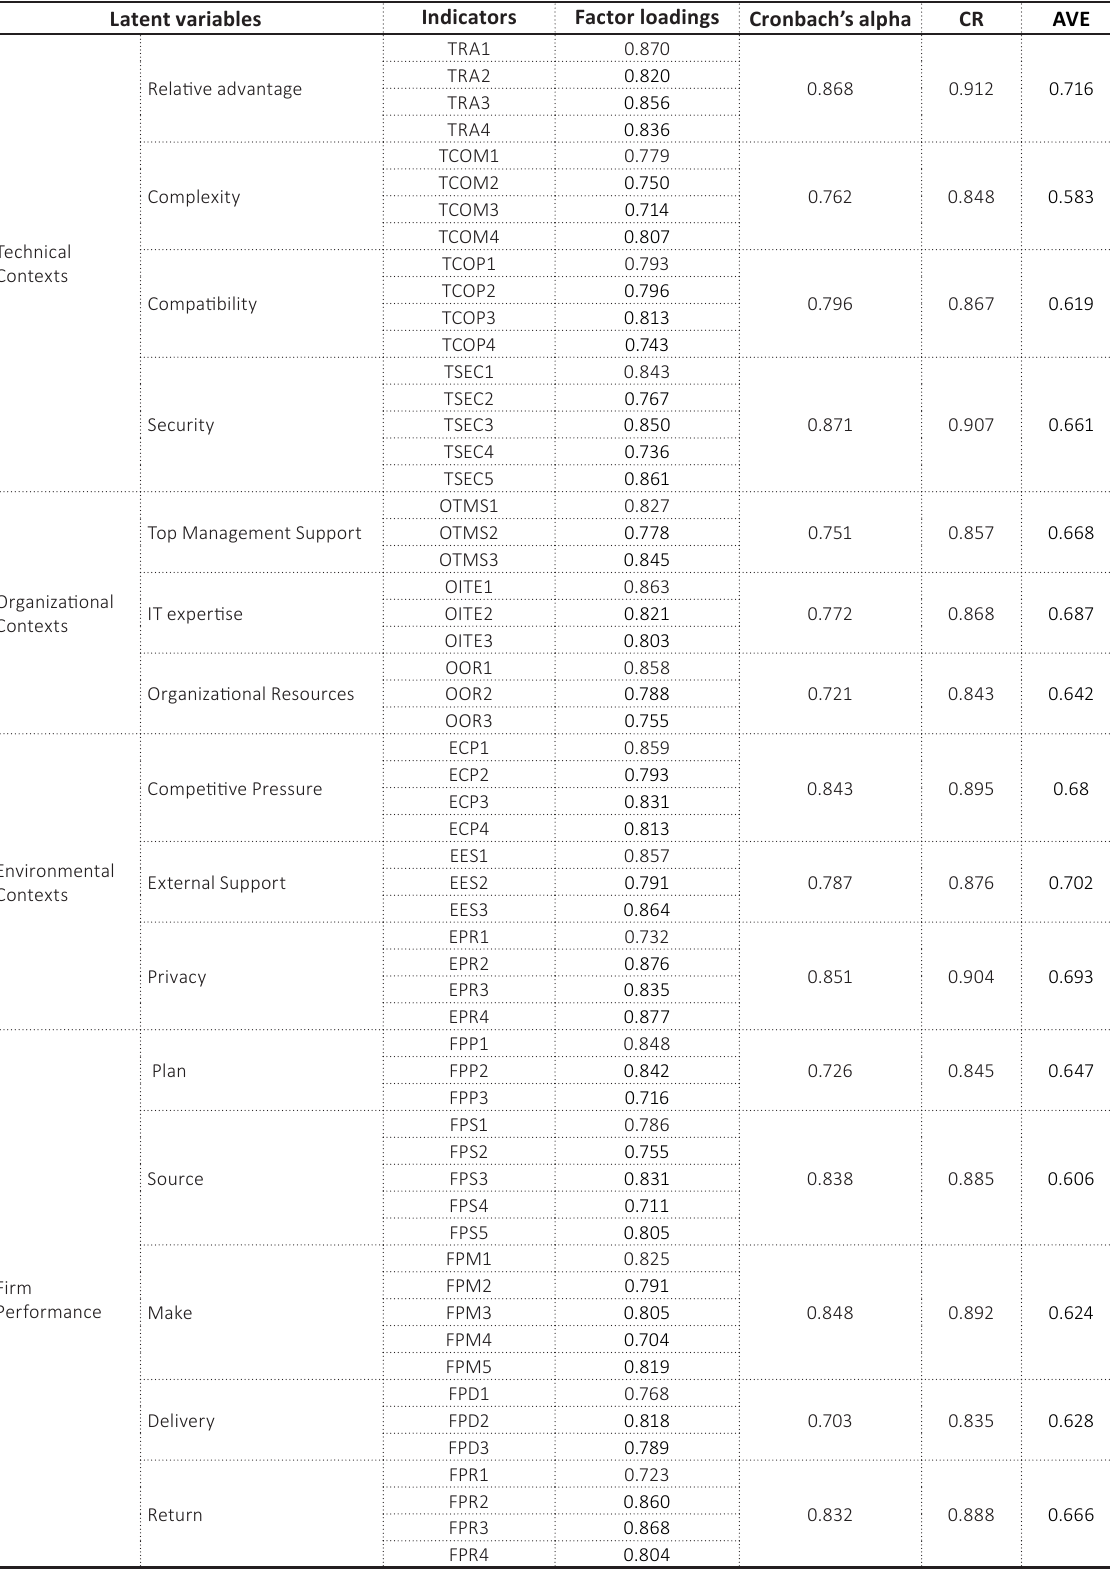
Table 1. Results of Outer Loading, Cronbach’s Alpha, CR, and AVE for composite